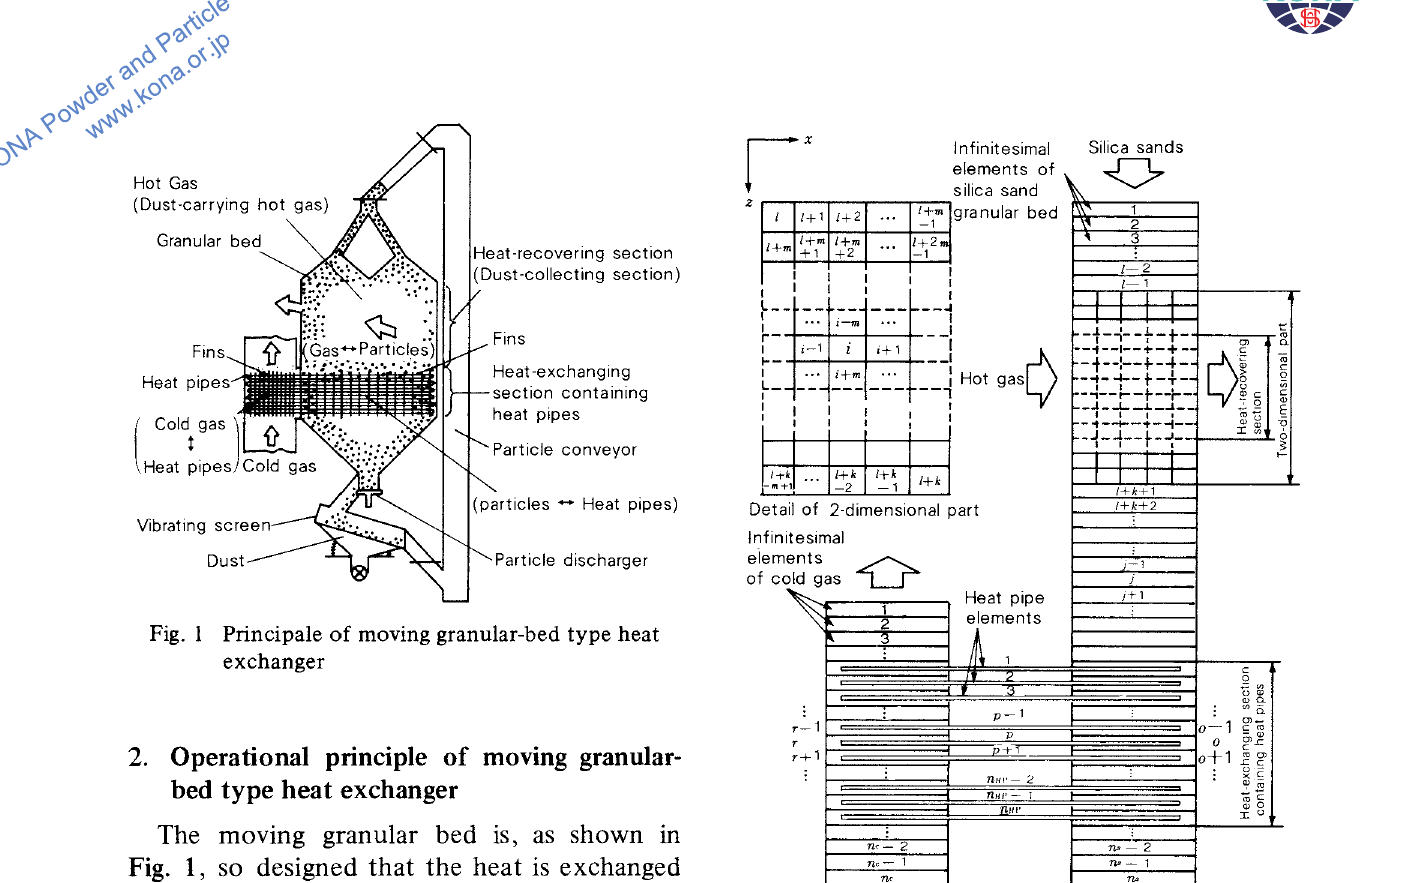
Fig. 1 Principale of moving granular-bed type heat exchanger